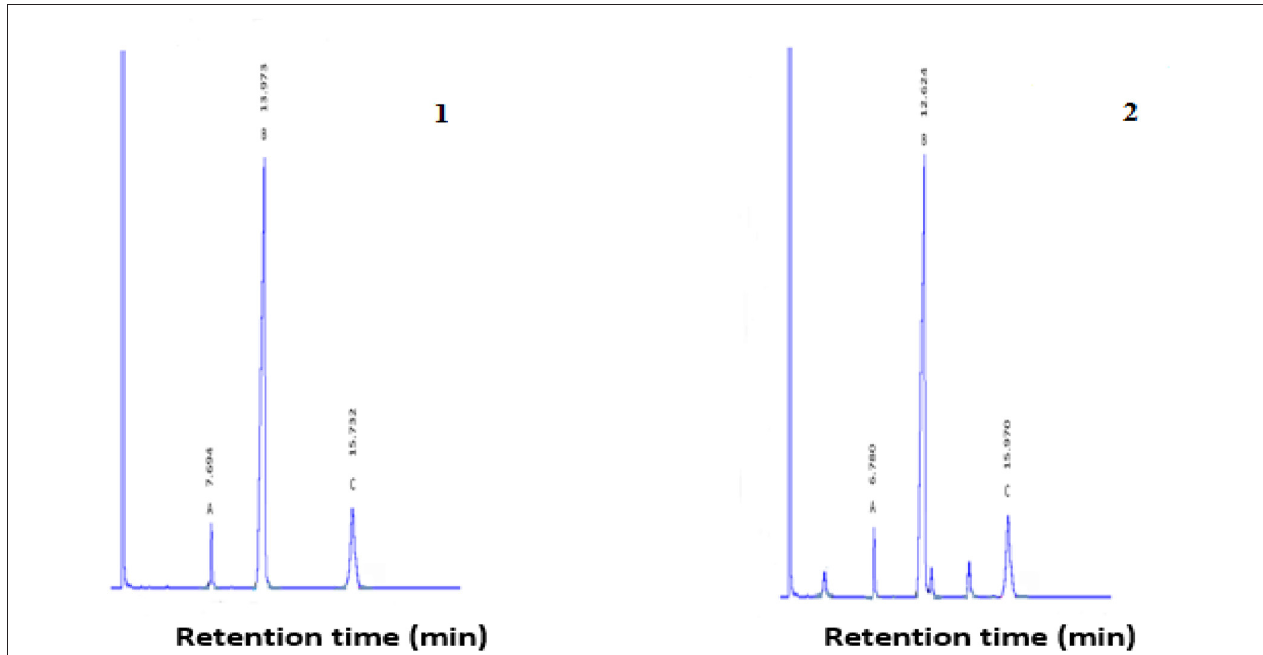
FIGURE 1 | Gas chromatography profile of geraniol butyrate (1) and citronellyl butyrate (2) obtained from the esterification reaction after 48h at 37 ◦ C. 1A: Remaining geraniol, 1B: Geranyl butyrate formed, and 1C: Remaining butyric acid. 2A: Remaining citronellol, 2B: Cotronellyl butyrate formed, and 2C: Remaining butyric